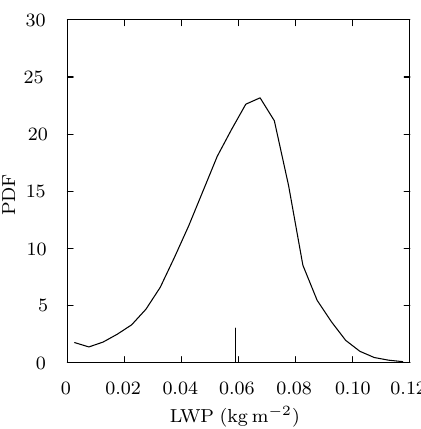
Figure 4. Probability density function of liquid water path. The vertical line corresponds to the mean LWP.